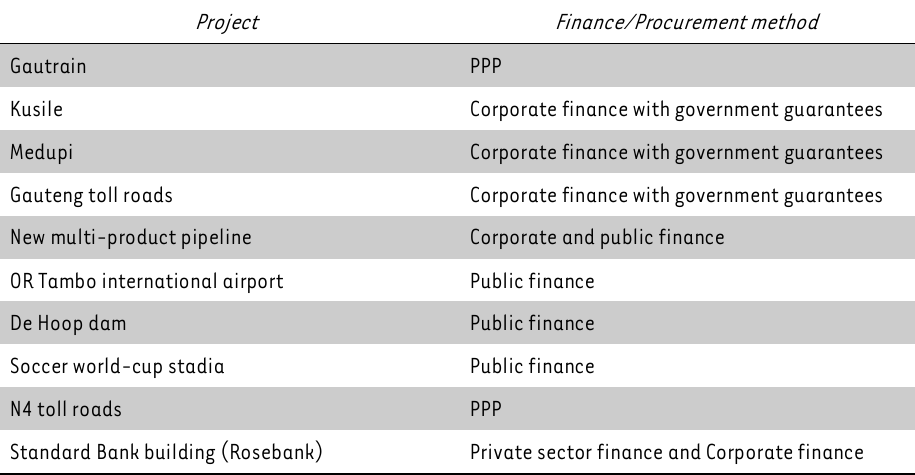
South African infrastructure projects and the financing method